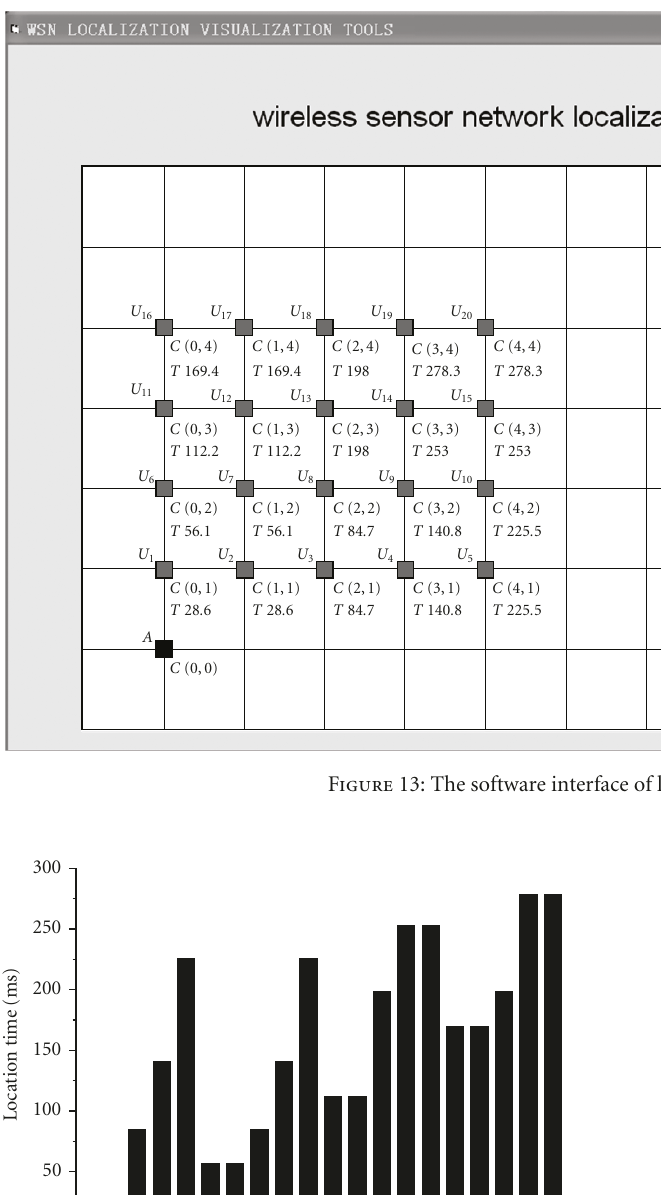
discrete power levels. Before implementing localization, RSSI thresholds corresponding to di ff erent power levels are ascertained by radio calibration and then stored in MCU flash, which can be used to distinguish neighboring